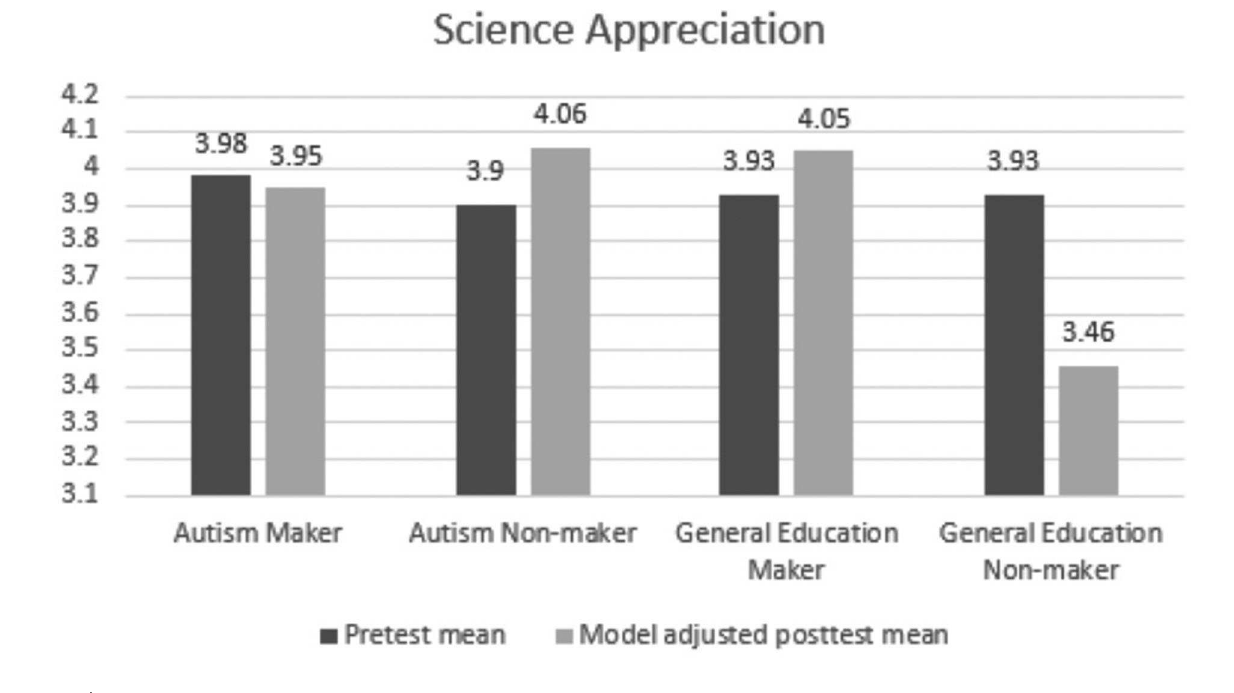
FIGURE 6 | Estimated means for the Science Appreciation construct.